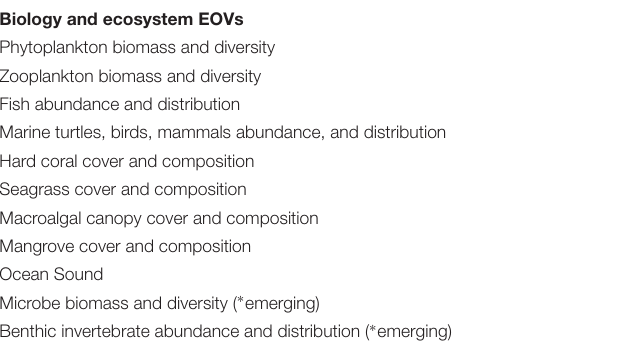
TABLE 1 | GOOS Biology and Ecosystems Panel supported EOVs (October 2018).